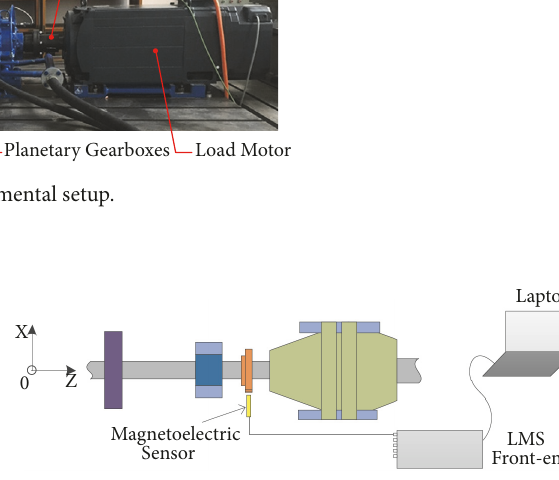
Figure 13: Schematic of entire experimental system.